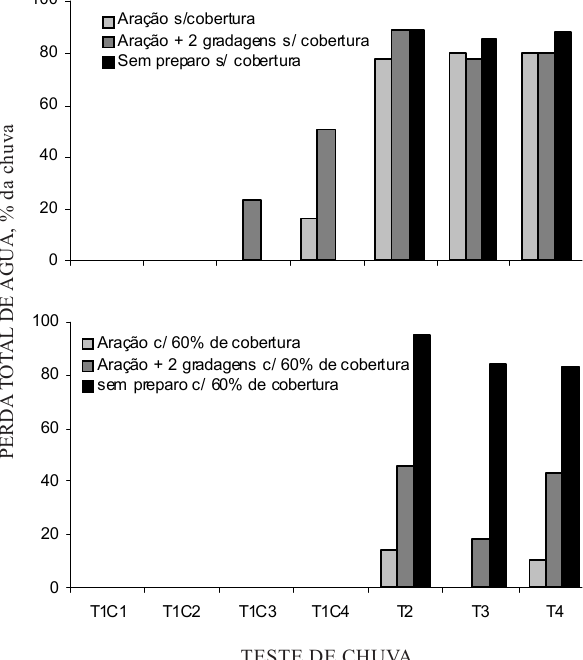
Figura 2. Perda total de água nos testes de chuva simulada realizados nos tratamentos estudados (T1, T2, T3 e T4 = testes de chuva 1, 2, 3 e 4, aplicados logo, 1, 20 e 35 dias após o preparo do solo, respectivamente; C1, C2, C3 e C4 = segmentos de chuva 1, 2, 3 e 4 de T1, com durações de 20, 20, 30 e 30 min, respectivamente; as chuvas dos Testes 2, 3 e 4 foram contínuas e tiveram 90 min de duração. Obs: não foi realizado o Teste 1 no tratamento sem preparo do solo, tanto na ausência quanto na presença de